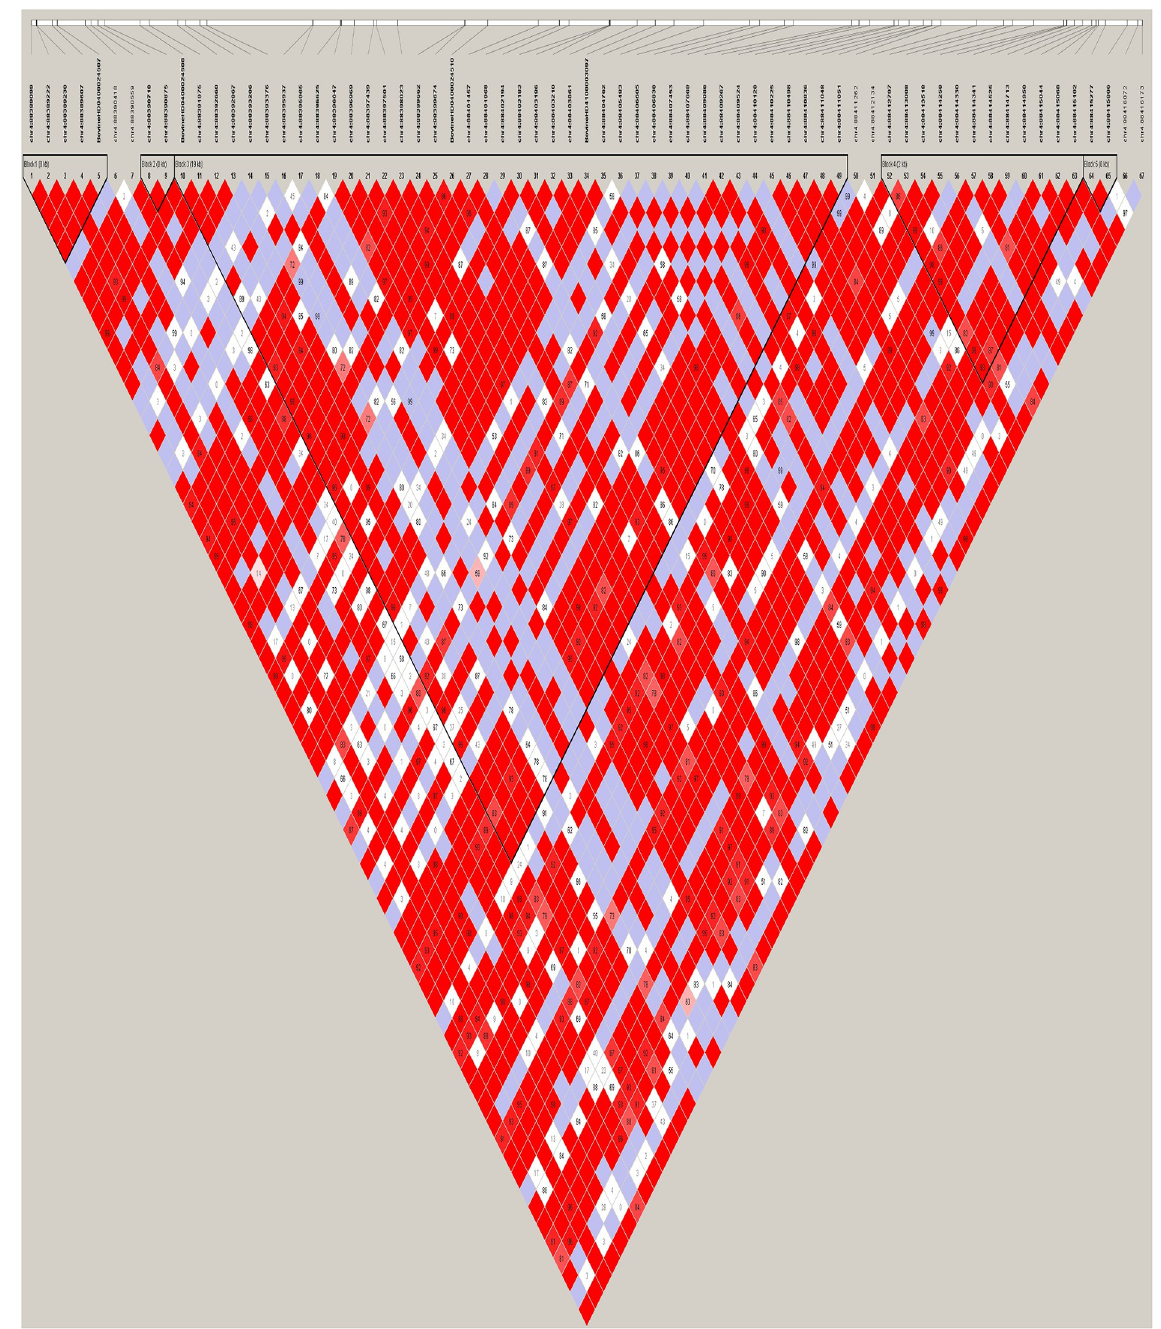
Fig 4. Linkage disequilibrium plot. The high LD block spans 19 kb, which harbors the most significant SNP for width of hind